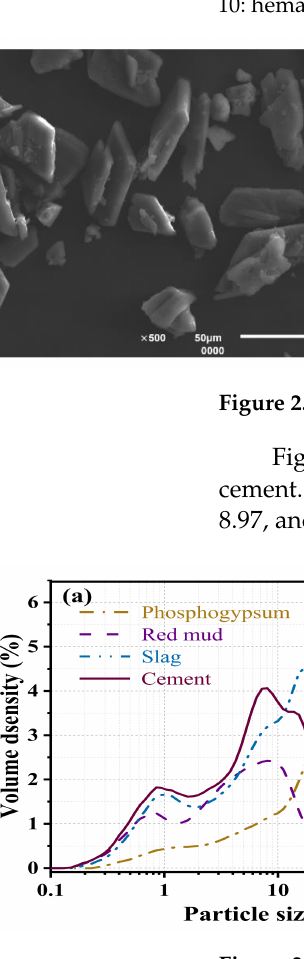
Figure 3. Particle size distributions of phosphogypsum, red mud, slag, and cement (( a ): volume density; ( b ): cumulative